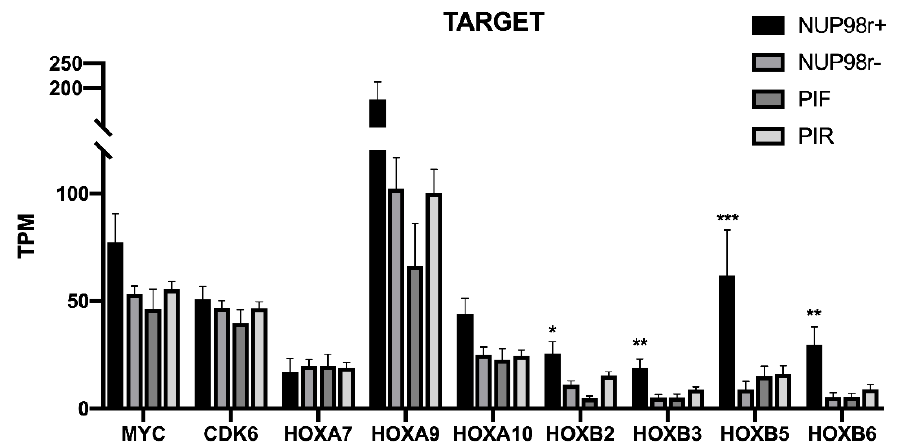
Figure 6 . Expression values of MYC, CDK6, HOXA and HOXB cluster genes in TARGET cohort, subdivided in NUP98r+ ( n = 21) and NUP98r − ( n = 137) patients, PIF ( n = 19) and PIR ( n = 175) patients. Only HOXB cluster genes are significantly higher in NUP98r+ patients ( t -test * p value < 0.01, ** p < 0.001, *** p < 0.0001), while no difference was detected comparing PIF and PIR patients.